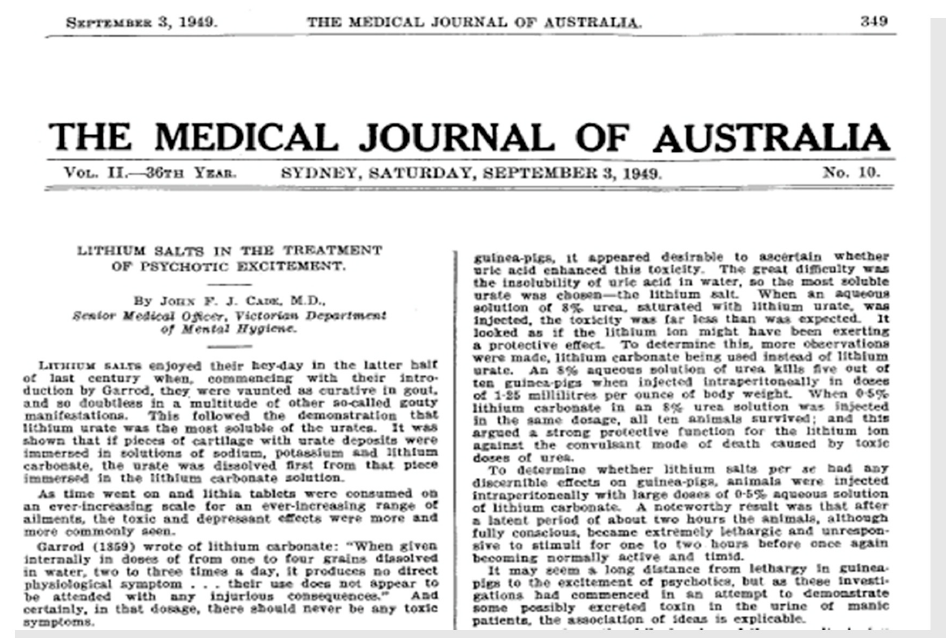
Figure 12. Medical Journal of Australia, Volume 3, September 1949, in which the results of the clinical experiments by John Cade about lithium salts and the handling of hectic manic and schizophrenic patients were published [61].